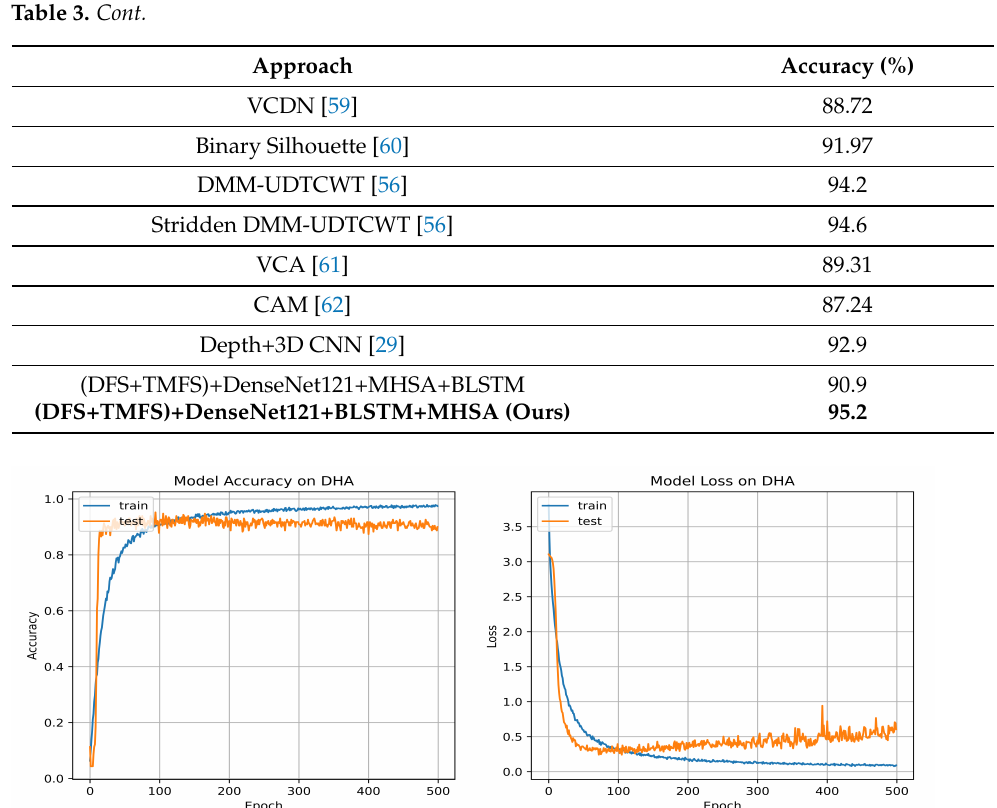
Table 3. Comparison of our highest action recognition accuracy (%) with state-of-the-art frameworks on the DHA test set.